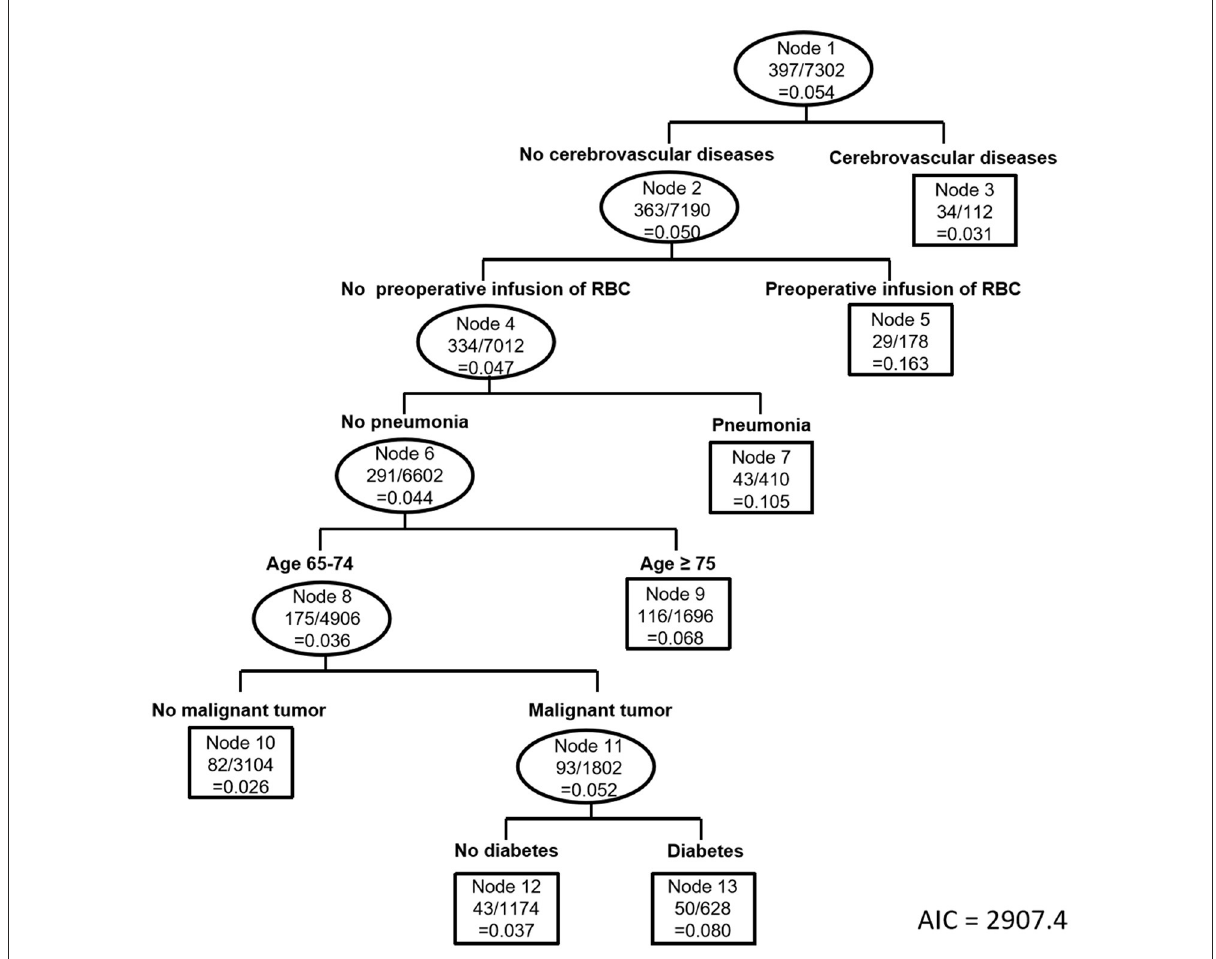
FIGURE2 Tree structure derived from all the potential confounding factors (Model 3).